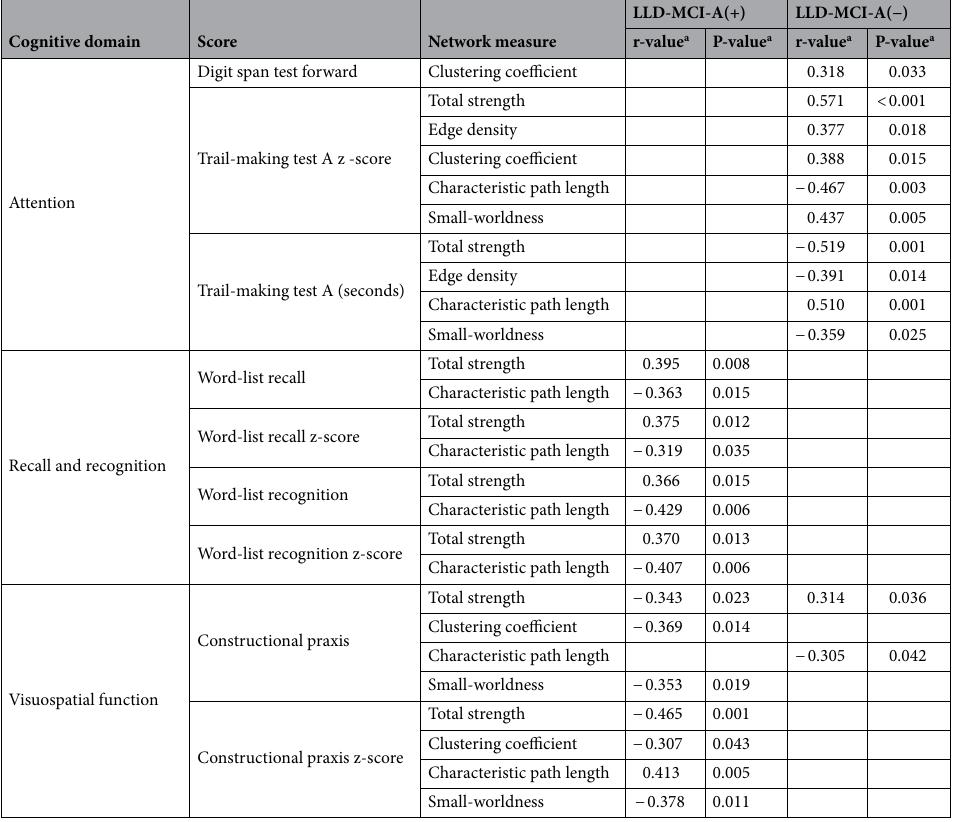
Table 2. Correlation between the global network measures and cognitive scores (significant results only). a Partial correlation coefficient, controlling for age, gender, and education level.